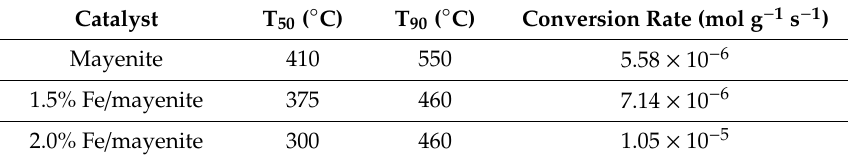
Table 2. Catalysts activity in terms of T 50 and T 90 and conversion rate at 365 ◦ C.